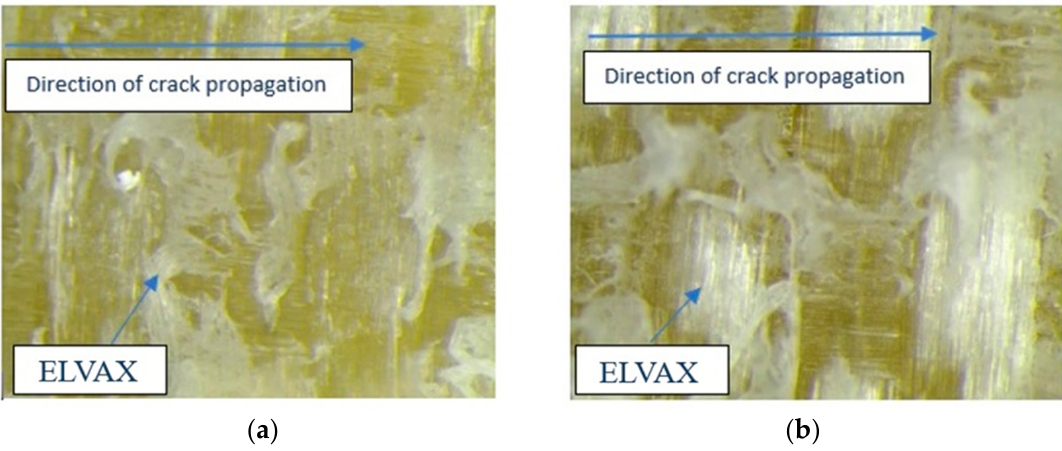
Figure 19. Optical microscopic images of Mixed-Mode I/II specimen ( a ) Bottom surface; ( b ) Top surface.